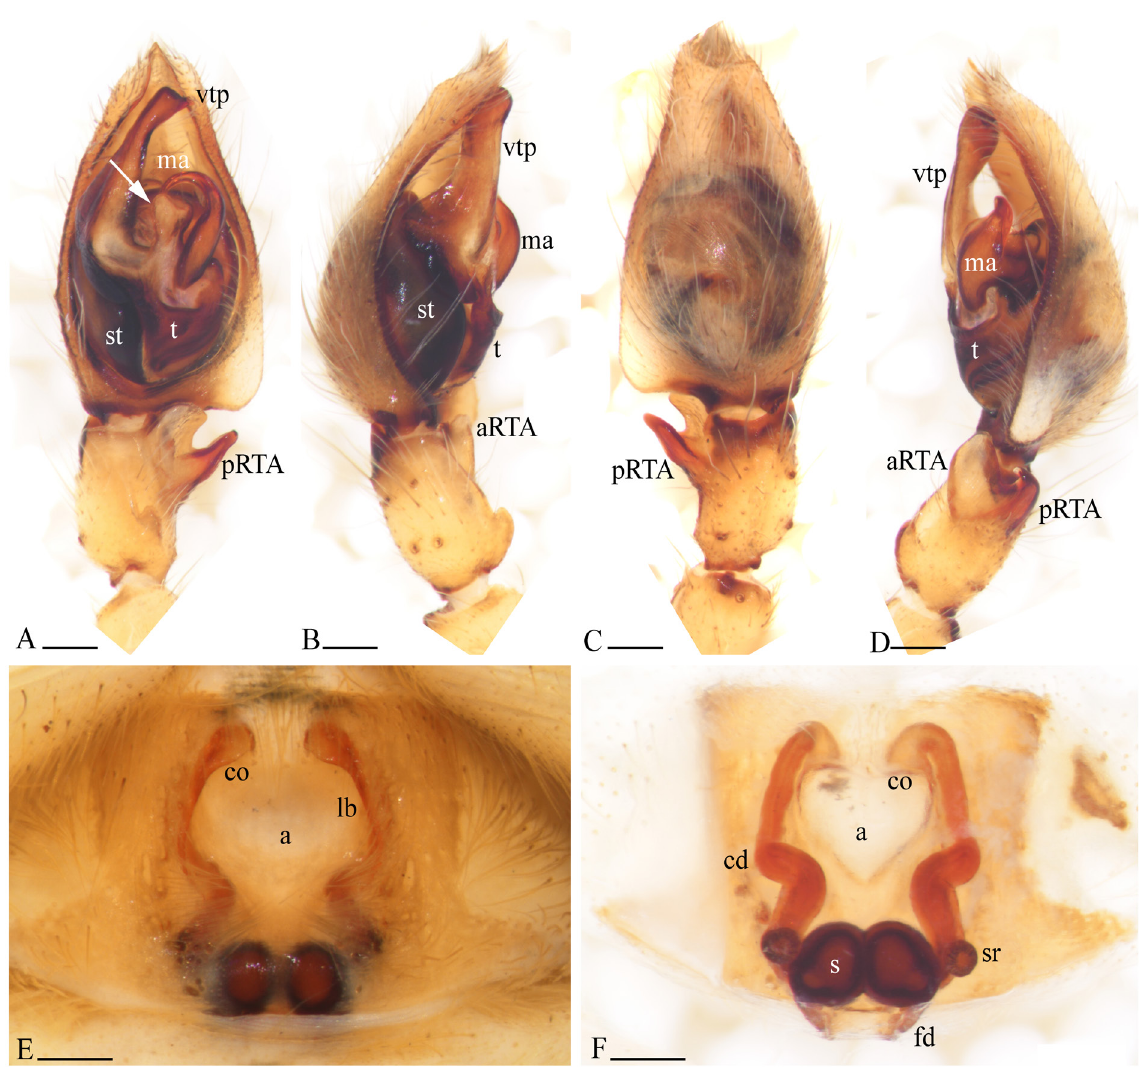
Fig. 26. Anyphaena dulceae sp. nov. A–D . Paratype, ♂ (CNAN-T01551). E–F . Paratype, ♀ (CNAN-T01552). A . Pedipalp, ventral view. B . Pedipalp, prolateral view. C . Pedipalp, dorsal view. D . Pedipalp, retrolateral view. E . Epigynum, ventral view. F . Epigynum, dorsal view. Scale bars: 0.2